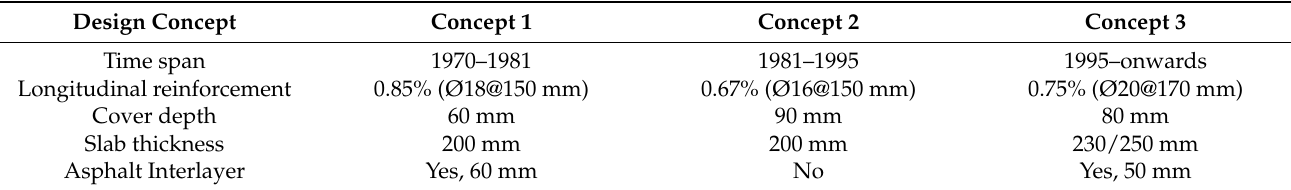
Table 1. Overview of design concepts for CRCP in